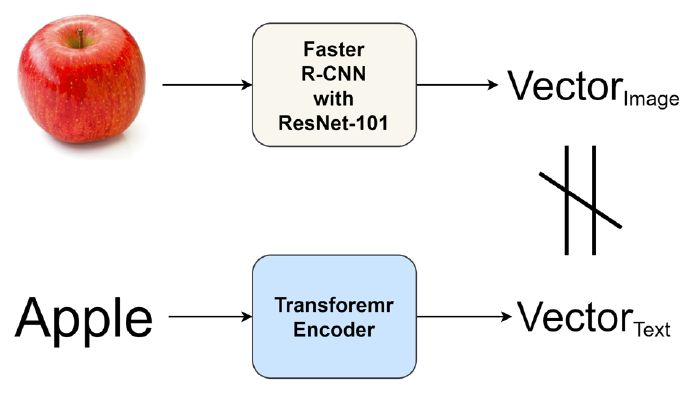
Figure 7. Compare vector values of images and